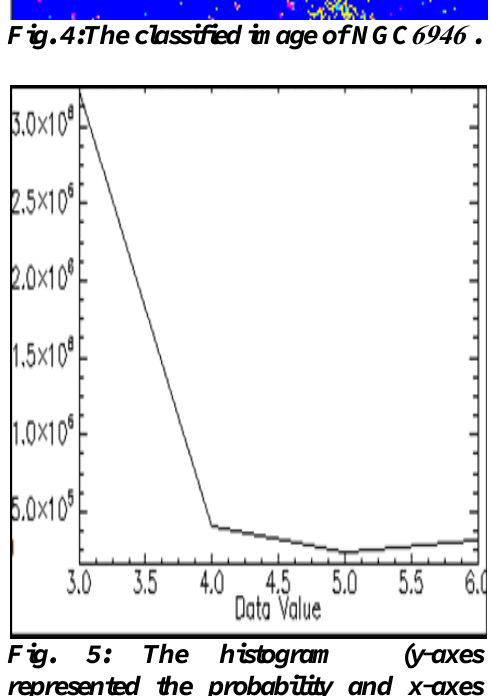
Fig. 3: The histogram (y-axes represented the probability and x-axes represented the intensity) of the original NGC 6946 galaxy (Three bands).